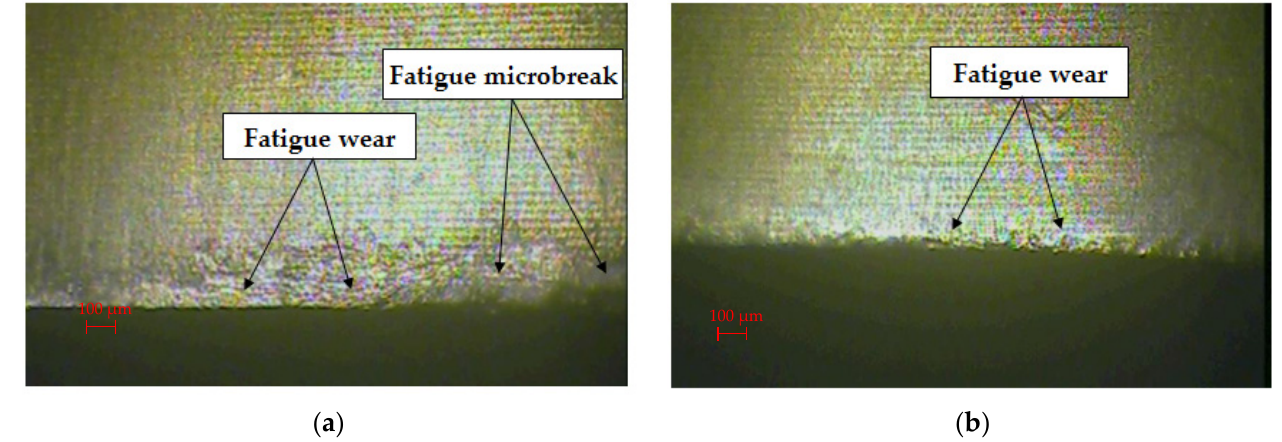
Figure 4. Edge and face wear of the punch at the 70,000 strokes: ( a ) uncoated; ( b ) coated.